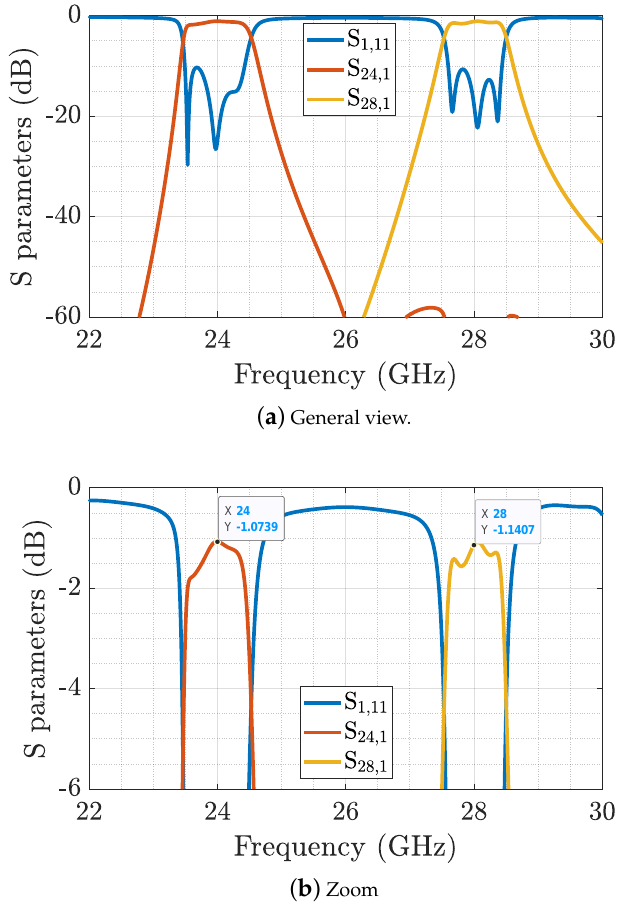
Figure 8. Diplexer S-parameters with lossy RT5880 TM substrate and metals (pin height = 2.8 mm).